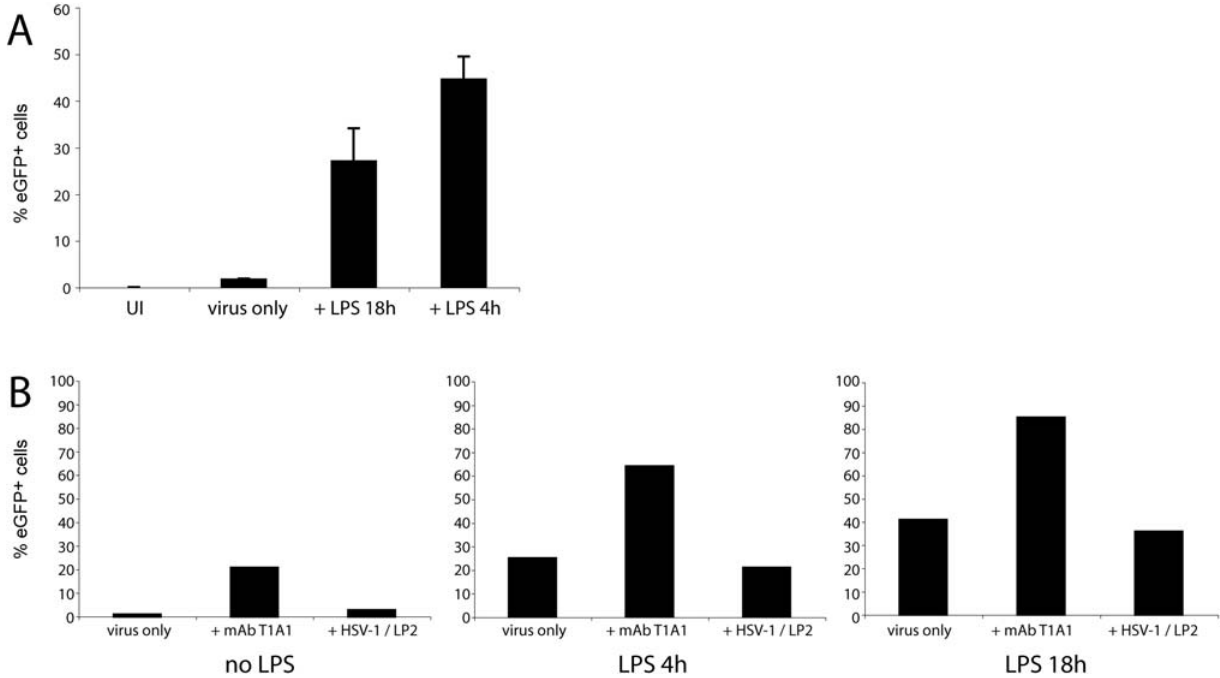
Figure 5. LPS reveals higher levels of RAW264.7 cell infection for both antibody-independent and antibody-dependent infections. A. RAW264.7 cells were left uninfected (UI) or incubated overnight with BAC + MHV-68 virions (2PFU/cell). LPS (100 ng/ml) was added to the infected cells for the full 18h, for 4h following infection, or not at all (virus only). Viral eGFP expression was then quantitated by flow cytometry. The bars show mean 6 SD of 3 replicate cultures. Equivalent results were obtained in 3 repeat experiments with RAW264.7 cells and 3 further experiments with peritoneal macrophages. B. RAW264.7 cells were incubated overnight with BAC + MHV-68 virions (2PFU/cell) with no LPS, with LPS for 4h before assay, or with LPS for the whole 18h. There was either no additional treatment (virus only), or the cultures were supplemented with the gp150-specific mAb T1A1 (10 m g/ml) or with LP2-treated HSV-1 virions. LP2, kindly provided by Ms. S.Bell (Division of Virology), is a gD-specific IgG2a neutralizing mAb and was added at concentrations sufficient to ablate HSV-1 infectivity (data not shown). Viral eGFP expression was measured by flow cytometry. The data are from 1 of 2 equivalent experiments.